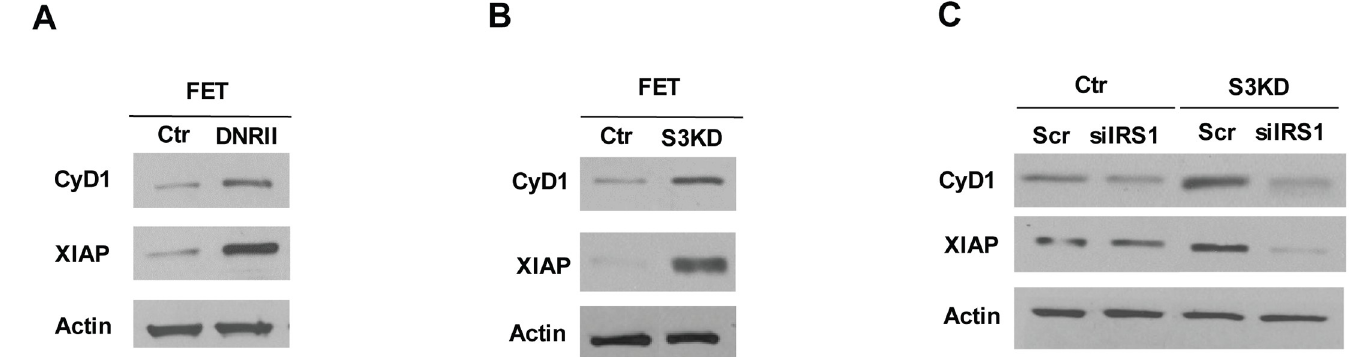
Fig 4. The TGF β /Smad3/IRS-1 signaling axis regulates expression of cyclin D1 and XIAP. (A&B) Expression of cyclin D1 and XIAP was higherin FET-DNRII (A) and Smad3 knockdown (B) cells. (C) Knockdown of IRS-1 led to reducedexpressionof cyclin D1 and XIAP in Smad3 knockdown cells.